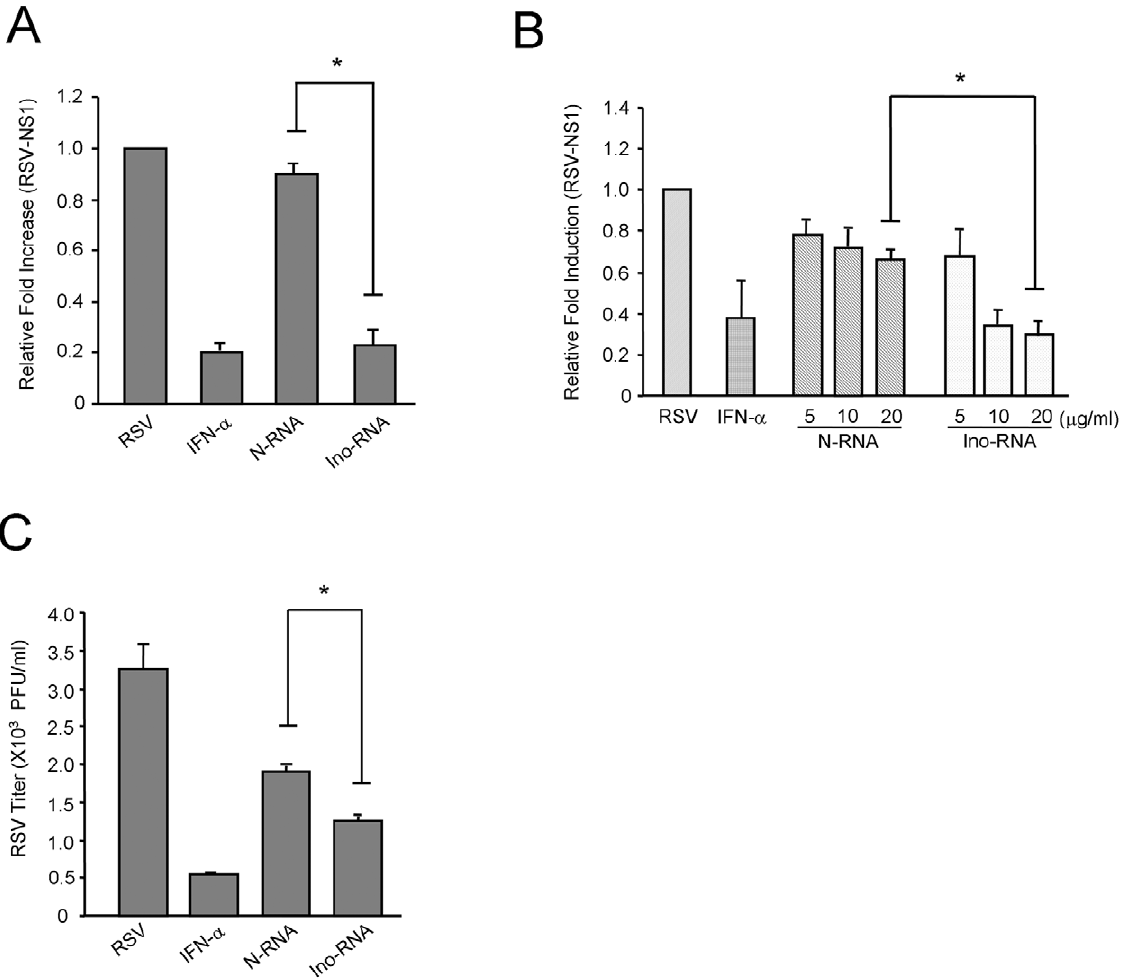
Figure 3. RSV replication is reduced by Ino-RNA treatment. Panels A , PHBE cells, were treated with 10% Ino-RNA (20 m g/ml for), N-RNA (20 m g/ml), or IFN- a (1000 Units/ml) for 24 hr prior to RSV infection at 0.1 PFU/cell. Cells were collected after an additional 24 hr, for RNA extraction. Total RNA from infected cells were extracted for RT-PCR quantification of RSV-NS1 transcript (n $ 3). Panel B , BEAS-2B cells were treated with 10% Ino-RNA (5, 10, 20 m g/ml), N-RNA (5,10, 20 m g/ml) (n $ 3). Panel C , BEAS-2B cells were treated as above and after 48 hr infection with RSV at MOI of 0.1 PFU/cell, plaque assays were performed (n=3). Error bars indicate standard error of the mean ( 6 SEM, *p , 0.05).